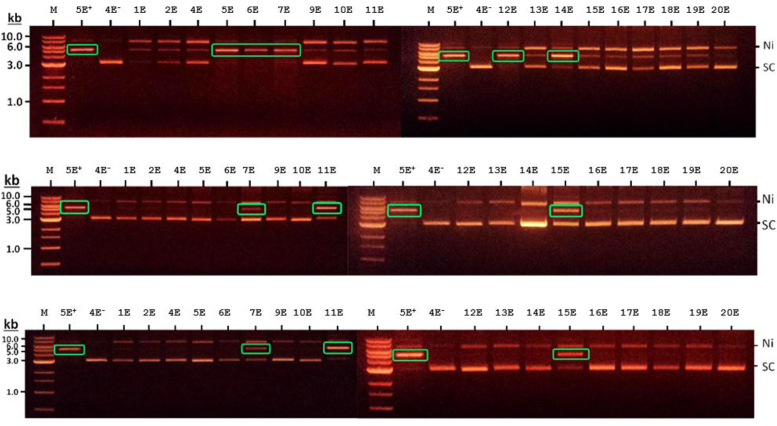
Agarose gel electrophoresis analysis of samples from a plasmid cleavage assay using the ‘E’ series of plasmids described previously (27). From top to bottom the gels show the effect of the purified HsdR incubated with MSfus, M\documentclass[12pt]{minimal}
\usepackage{amsmath}
\usepackage{wasysym} 
\usepackage{amsfonts} 
\usepackage{amssymb} 
\usepackage{amsbsy}
\usepackage{upgreek}
\usepackage{mathrsfs}
\setlength{\oddsidemargin}{-69pt}
\begin{document}
}{}$^{1}\!\!/_{\!2}$\end{document}S and M\documentclass[12pt]{minimal}
\usepackage{amsmath}
\usepackage{wasysym} 
\usepackage{amsfonts} 
\usepackage{amssymb} 
\usepackage{amsbsy}
\usepackage{upgreek}
\usepackage{mathrsfs}
\setlength{\oddsidemargin}{-69pt}
\begin{document}
}{}$^{1}\!\!/_{\!2}$\end{document}Sfus on the plasmid. The gels show three different plasmid DNA species. The species that occurs at the top of each gel lane has a single strand cut and is ‘nicked’ (Ni). Below this is the linearised species, when both strands have been cut by enzymatic activity (highlighted by green boxes). The lowest species is the uncleaved supercoiled DNA (SC). The lanes marked M are molecular size markers (kb). Lanes marked 5E+ and 4E− are plasmids incubated with HsdR plus CC398-1 MTase that contain a single site or no site for the RE and act as positive and negative controls, respectively.